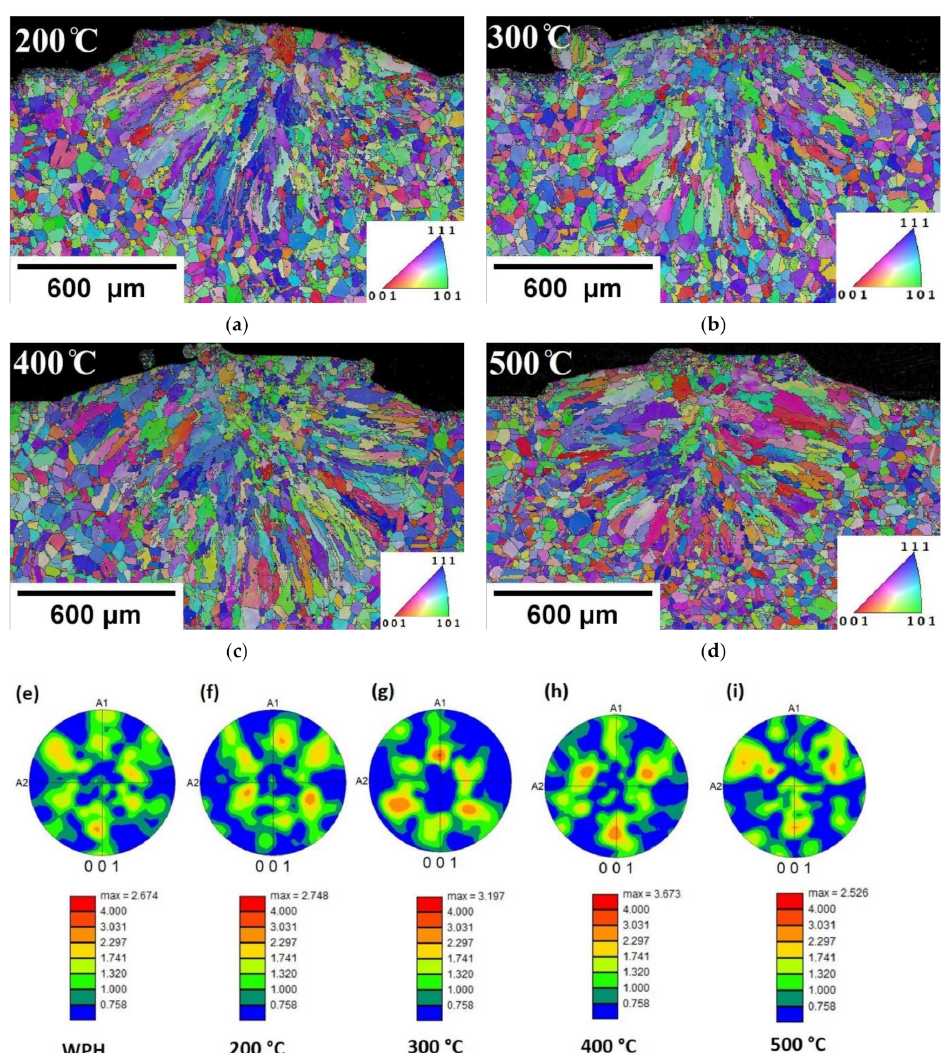
Figure 7. EBSD inverse pole figure maps for preheating base plate single track transverse